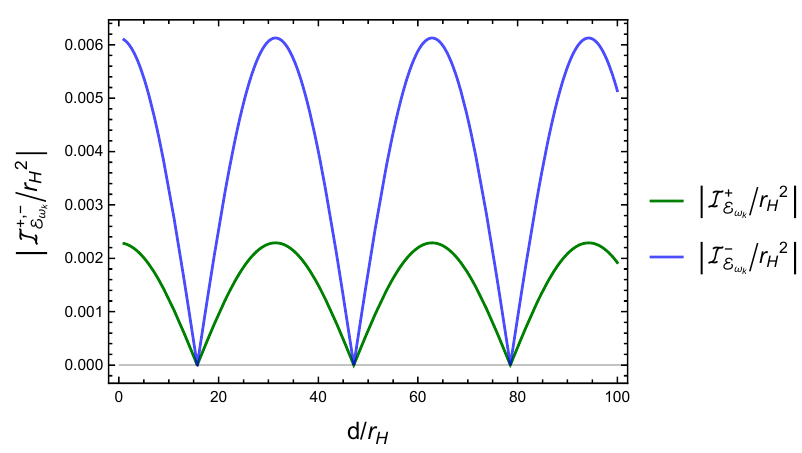
and |I − are plotted in green and blue lines, respectively | /r 2 | /r 2 H H E ωk E ωk = 0 . 1 .The detector transition energy is fixed at ∆ E = 0 . 5 . k